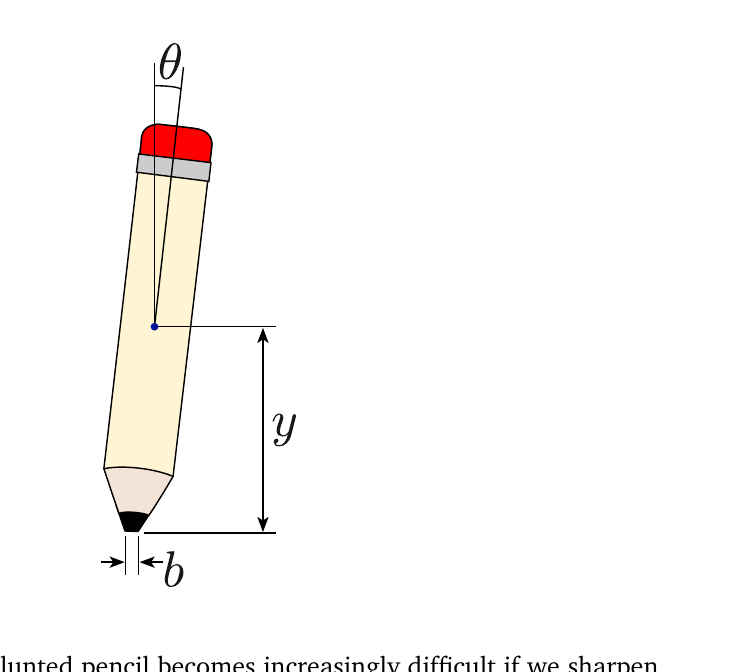
Figure 2.1: Balancing a blunted pencil becomes increasingly difficult if we sharpen it. The limits b → 0 and θ → 0 do not commute, and provide an example of singular